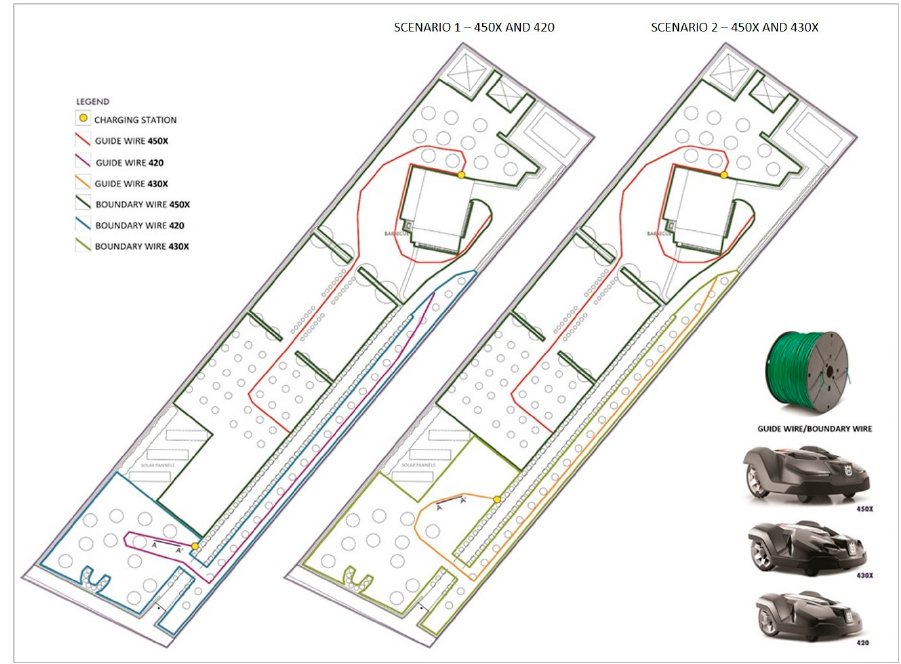
Figure 3. The two scenarios of management and the autonomous mowers involved in the study.